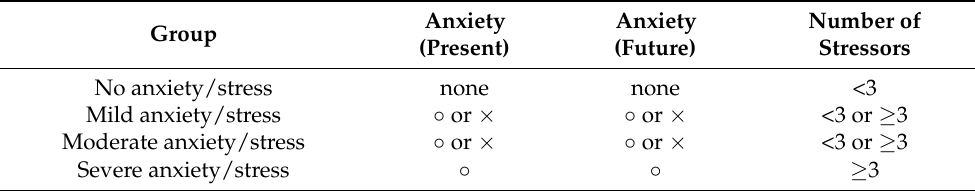
Anxiety Anxiety Number of (Present) (Future) Stressors